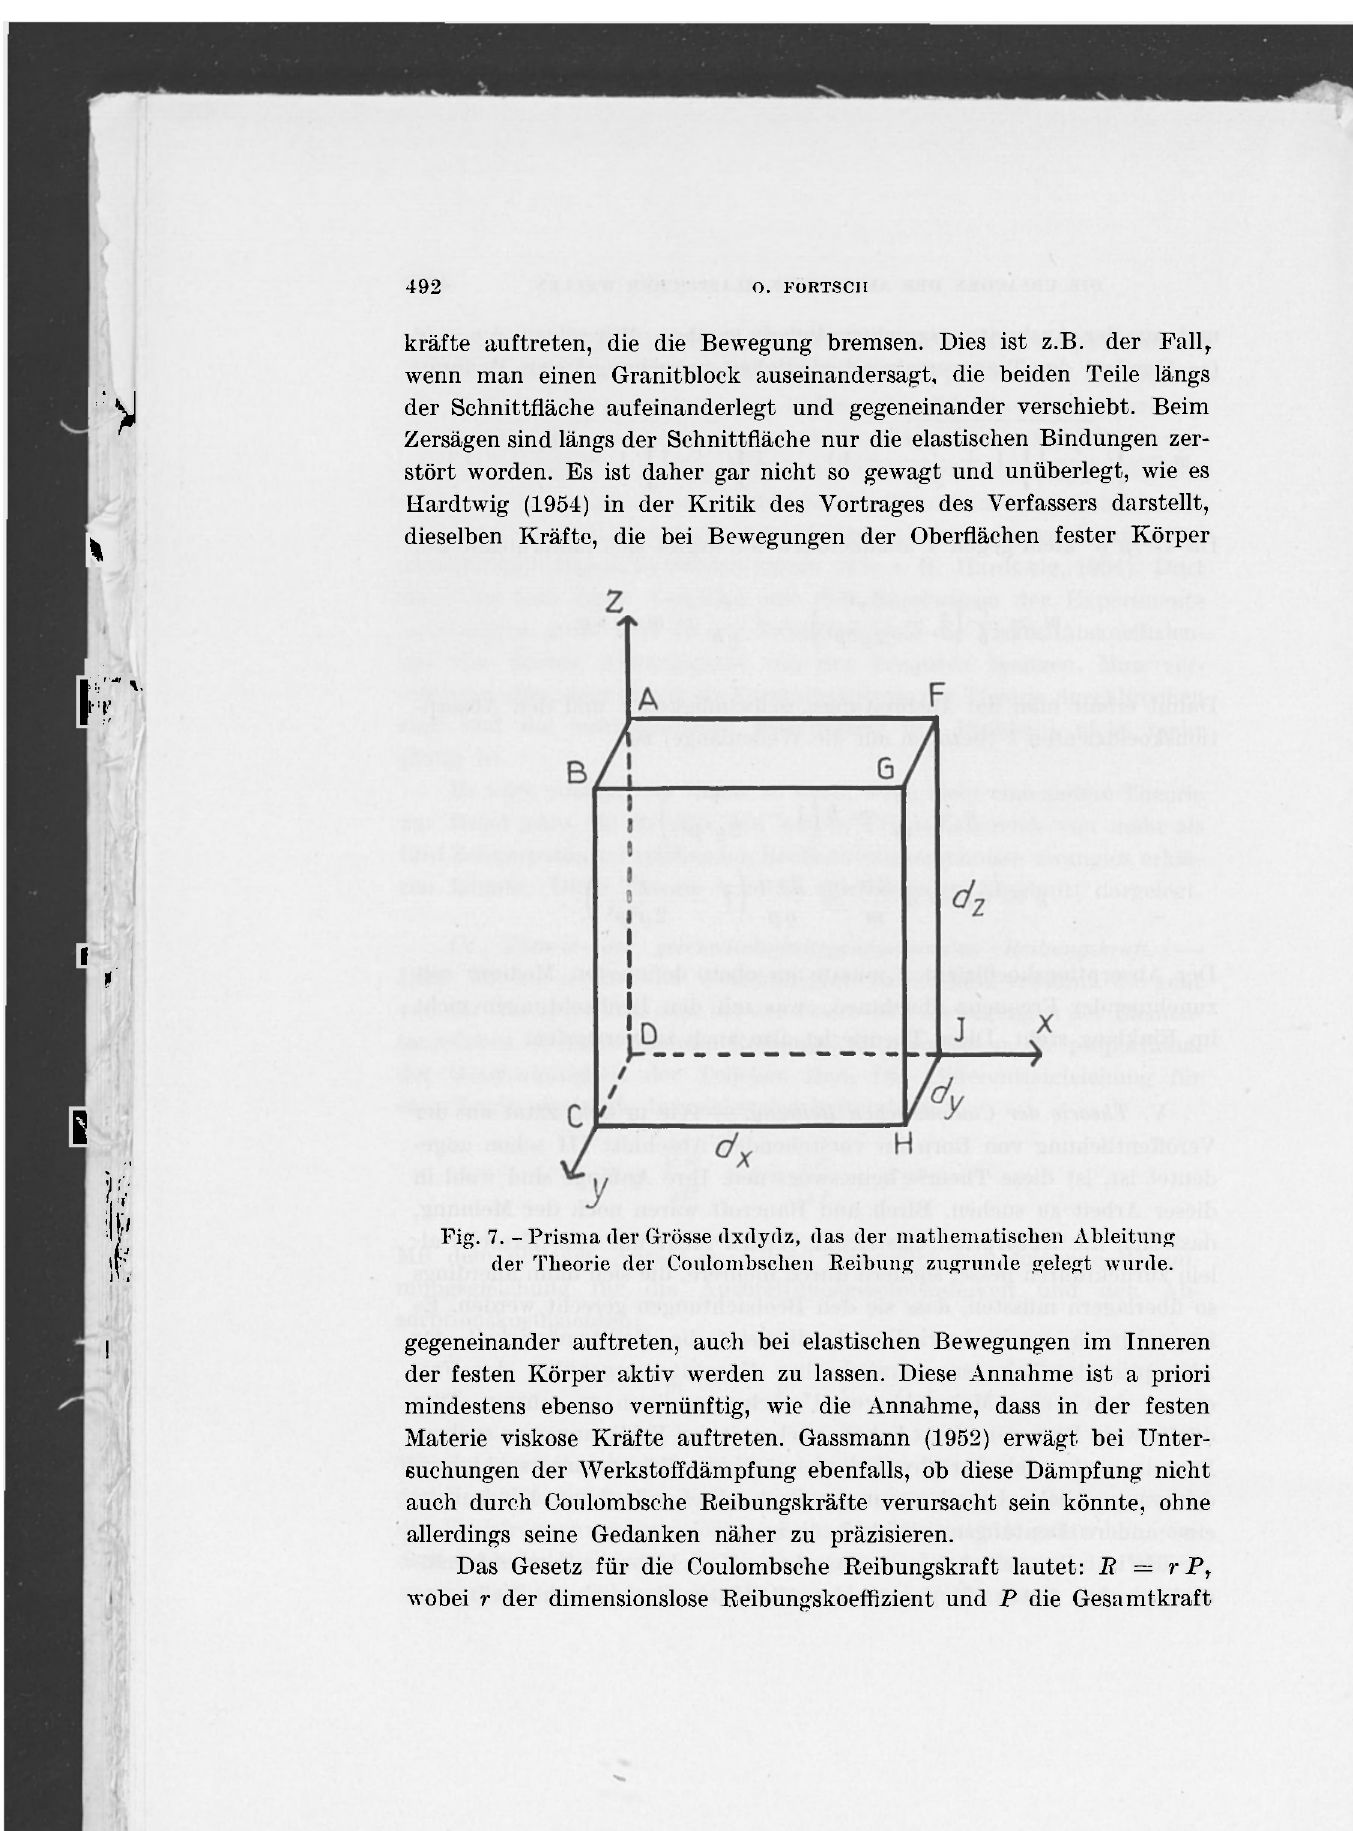
Fig. 7. - Prisma der Gròsse dxdydz, das der mathematischen